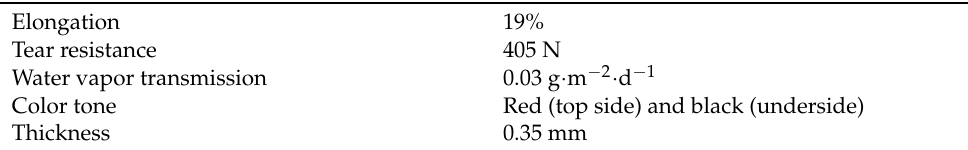
Table 3. Technical specifications of Monarflex RMB350 (http://www.necoflex.is, accessed on 10 October